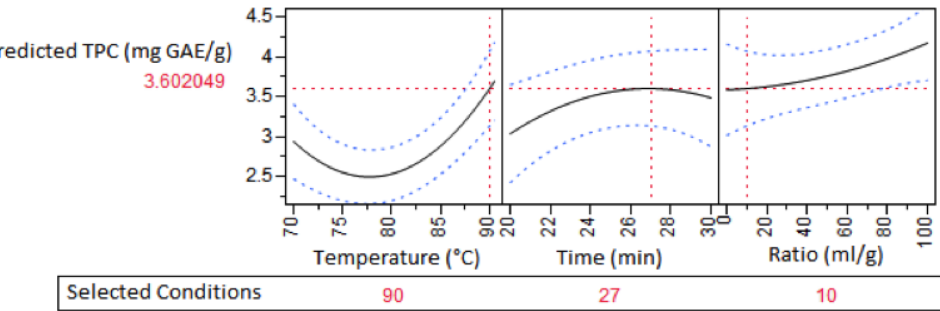
Figure 2. Impact of extraction conditions on predicted total phenolic content (TPC) of dried E. tirucalli .